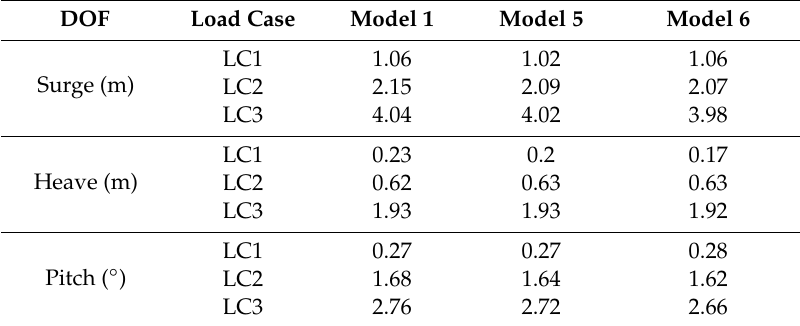
Table 14. Amplitudes of the stationary motion of the inclined upper column